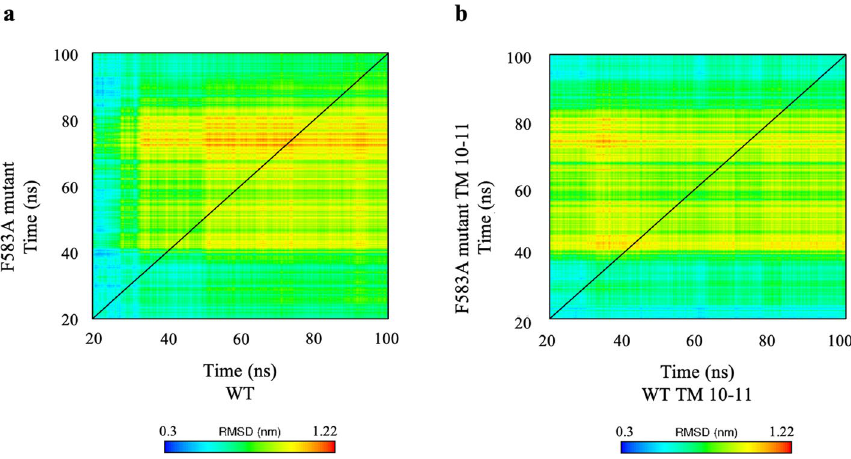
Figure 5. 2D-Matrix representation of mutual backbones atoms’ RMSD of the (a) WT-MRP1 and F583A- MRP1 mutant and (b) WT’s helices 10–11 and F583A mutant’s helices 10–11, upon a comparison of representative simulations. The RMSD values of the mutant’s trajectory were calculated in relation to those of the WT. The values are given by color codes; blue and red represent high and low similarity, respectively, ranging from 0.3 to 1.22 nm. The diagonal best explains the mutual evolution of the stability of the WT’s and the F583A mutant’s